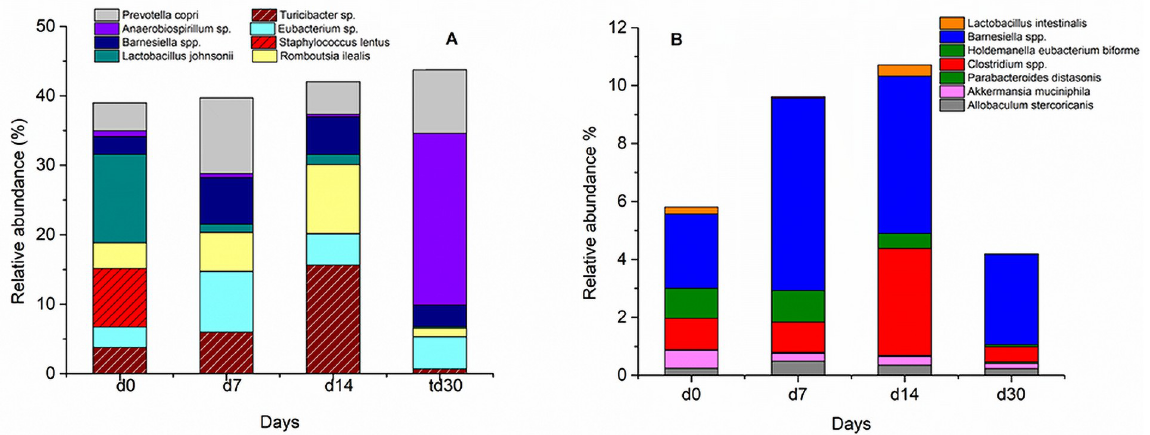
Fig 8. Temporal shift in gut microbiota in response to the Ca-Alg aerogel exposure, representing the species that increased, decreased, or totally disappeared due to the treatment.